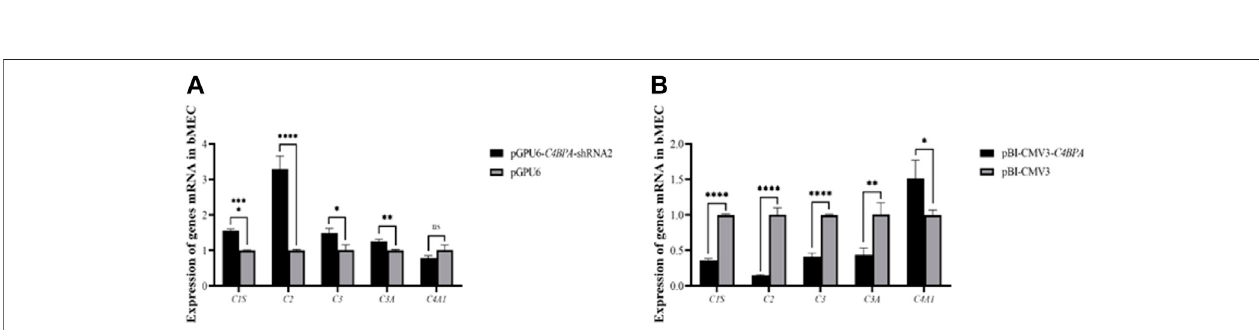
FIGURE 7 | (A) The mRNA expression of complement and coagulation cascade pathways related genes in bMECs after transfection with pGPU6- C4BPA - shRNA2. (B) The mRNA expression of complements and coagulation cascade pathways related genes in bMECs after transfection with pBI-CMV3- C4BPA .